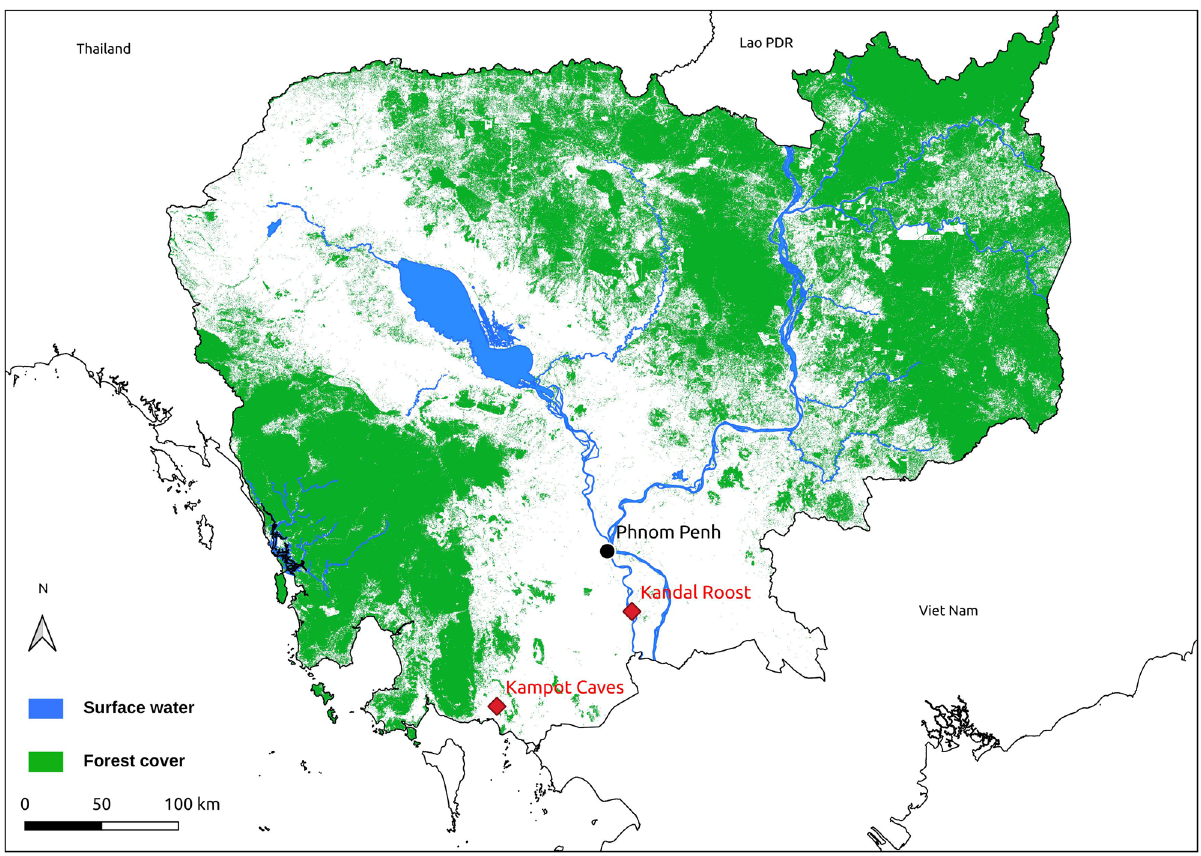
Figure 1. Map of Cambodia showing the two study sites (generated with QGIS 3.18, www. qgis.